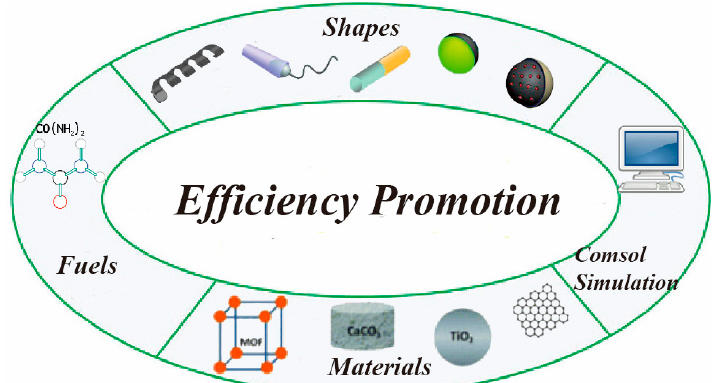
Figure 6. Conceptual diagram of the possible directions for improving energy conversion efficiency of micro-and nanomotors.